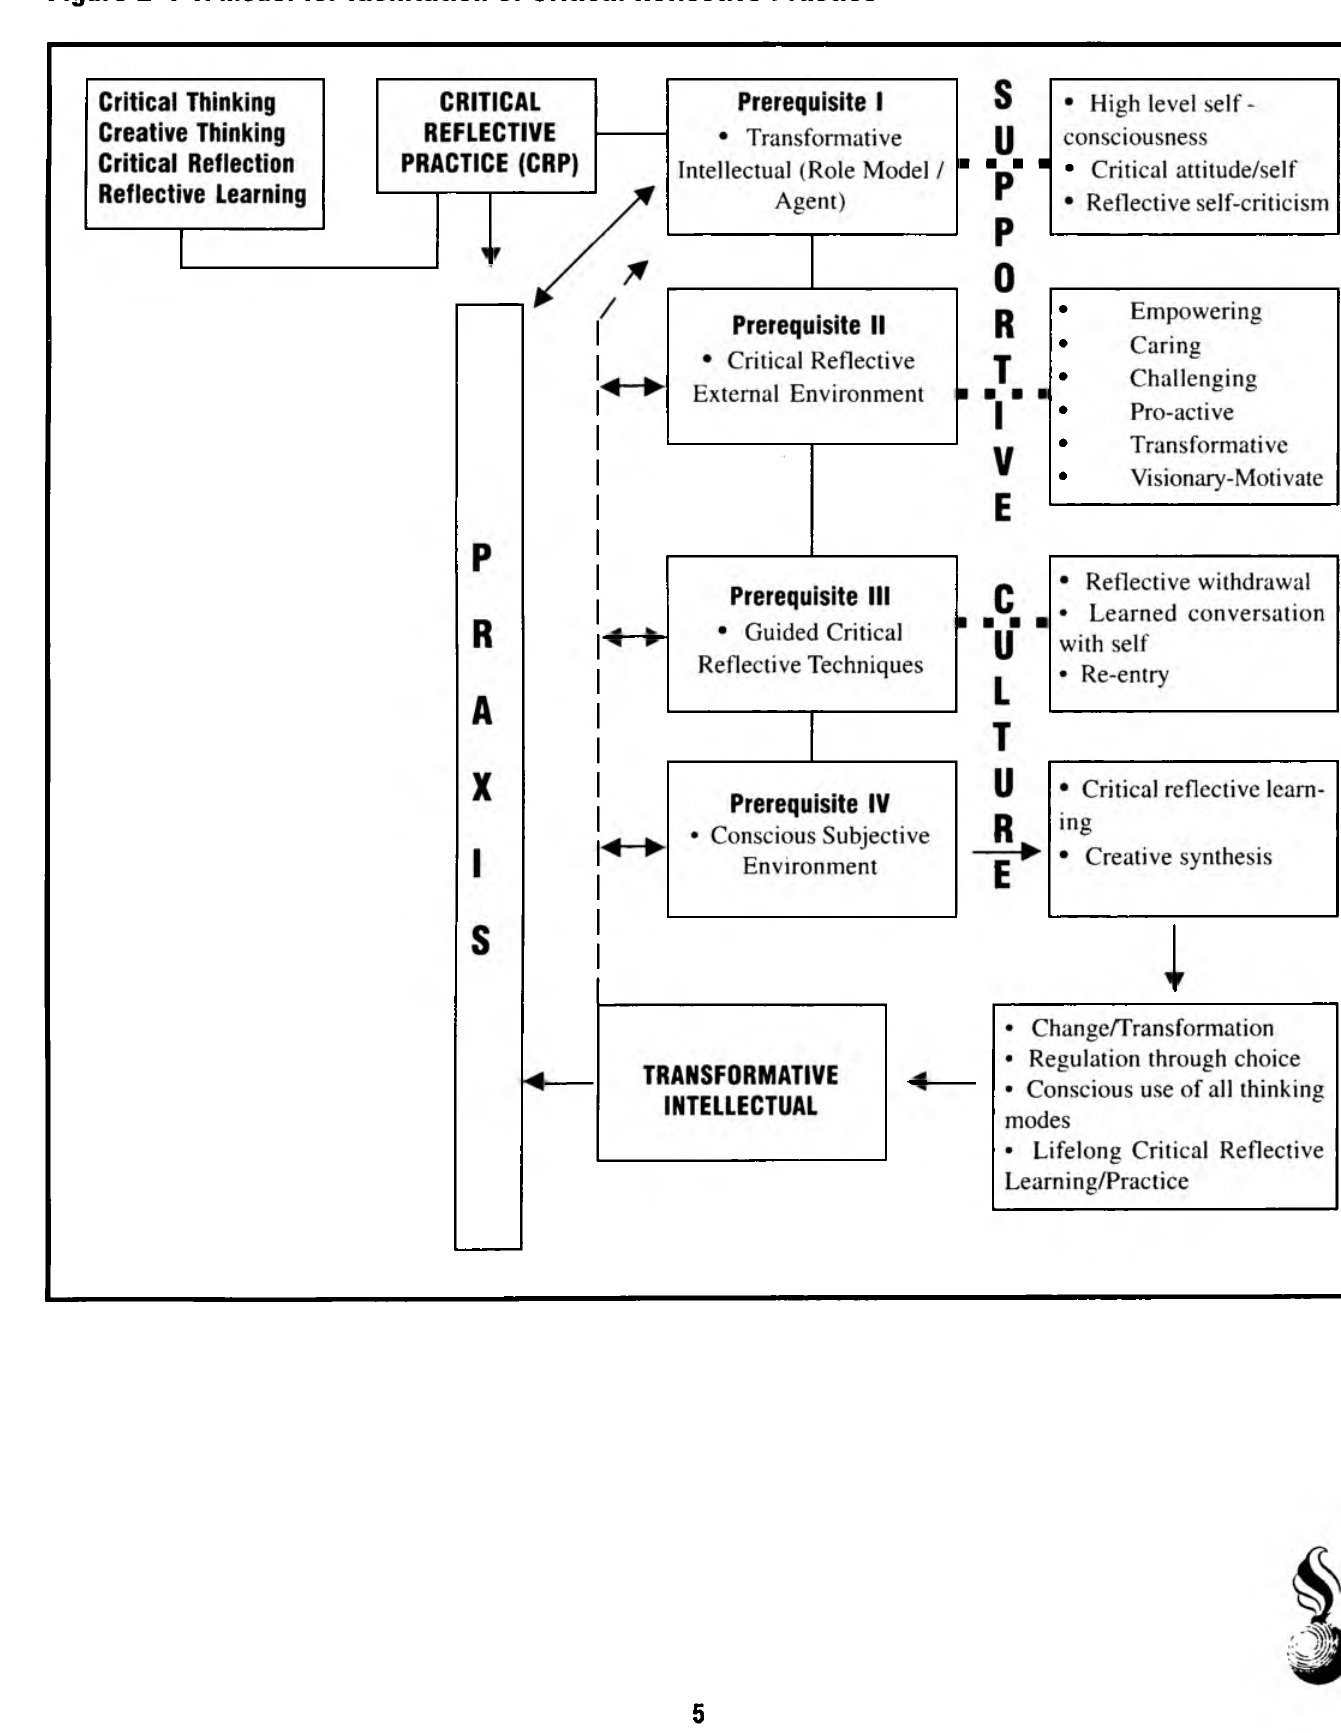
Figure 2 : A model for facilitation of Critical Reflective